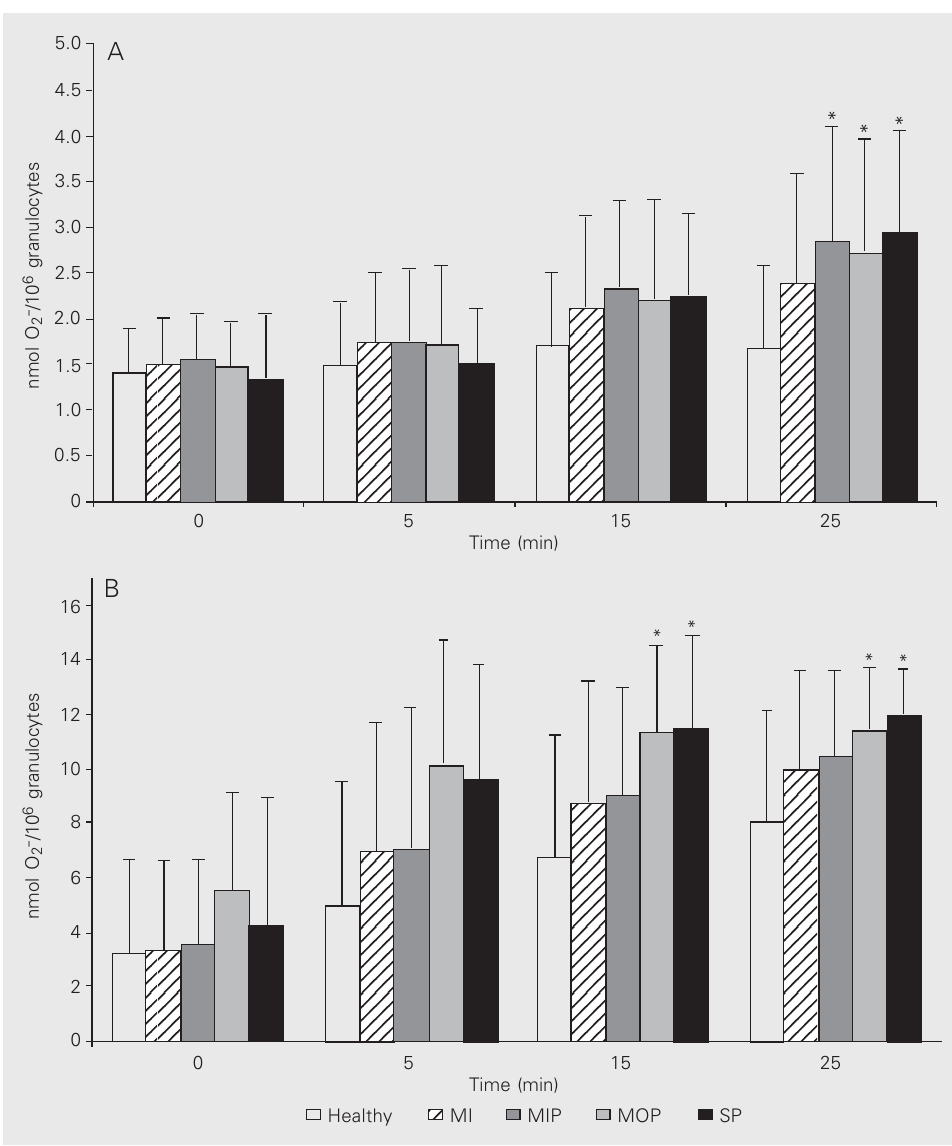
Figure 1. Superoxide release by granulocytes and monocytes from patients with asthma, grouped according to GINA di- agnostic criteria. Panel A , Spon- taneous superoxide (O 2- ) pro- duction was measured in granu- locytes from patients with asthma grouped according to GINA criteria and from healthy individuals at the indicated time points. The spontaneous super- oxide production by granulo- cytes from SP, MOP or MIP asthmatic patients was higher at 25 min of incubation, com- pared to healthy individuals (*P < 0.05, Duncan test). Panel B , Phorbol myristate acetate (PMA)-stimulated O 2- production was measured in granulocytes from patients with asthma grouped according to GINA cri- teria and from healthy individu- als at the indicated time points. The PMA-stimulated superoxide production by granulocytes from SP and MOP asthmatic patients was higher compared to healthy individuals at 15 and 25 min of incubation (*P < 0.05, Duncan test). SP = severe persistent (N = 6), MOP = moderate persist- ent (N = 12), MIP = mild persist- ent (N = 15), and MI = mild inter- mittent asthma (N = 11). Healthy individuals (N =